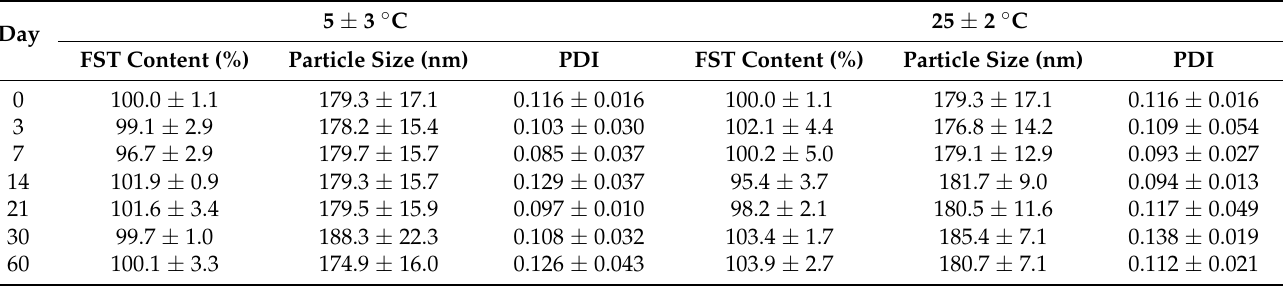
Table 4. Storage stability test of optimized FST–NP in 5 ± 3 °C and 25 ± 2 ° C.